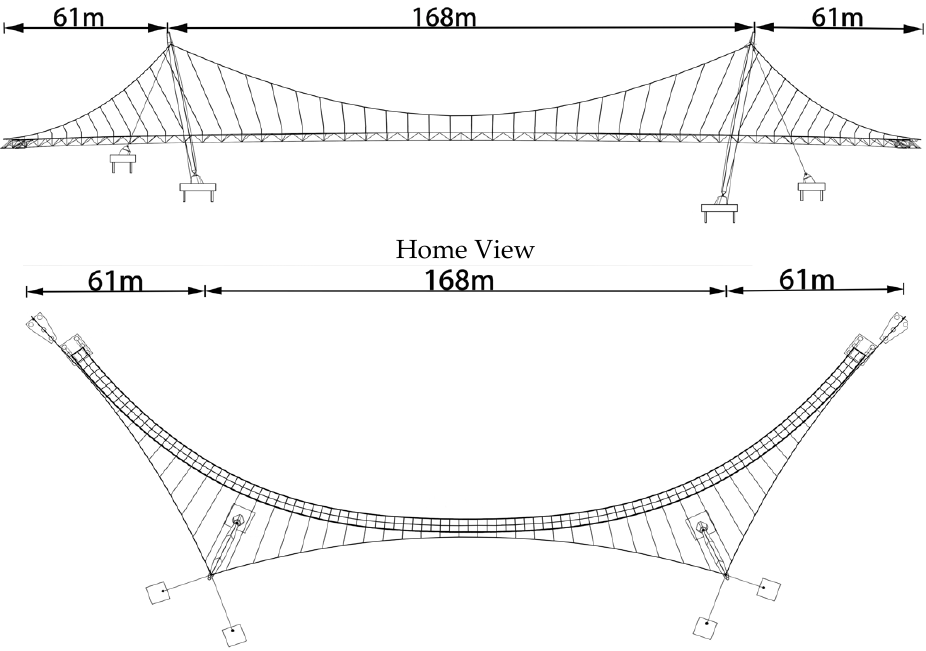
Figure 2. Schematic Diagram of Bridge.